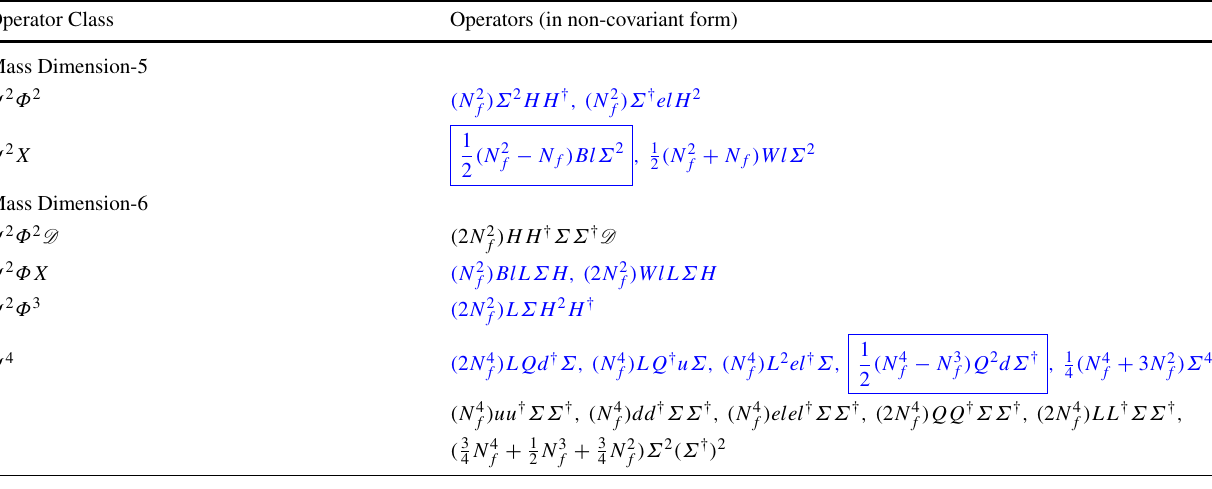
Table 36 SM + left-handed triplet Fermion( Σ ): Operators of mass dimensions-5 and -6 excluding pure SM operators Operator Class